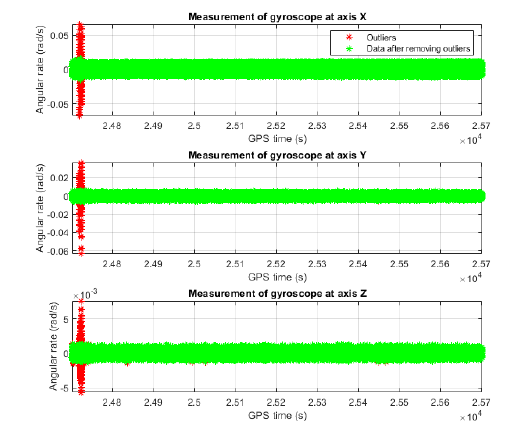
Figure 6 . Gyroscope measurements after removing outliers